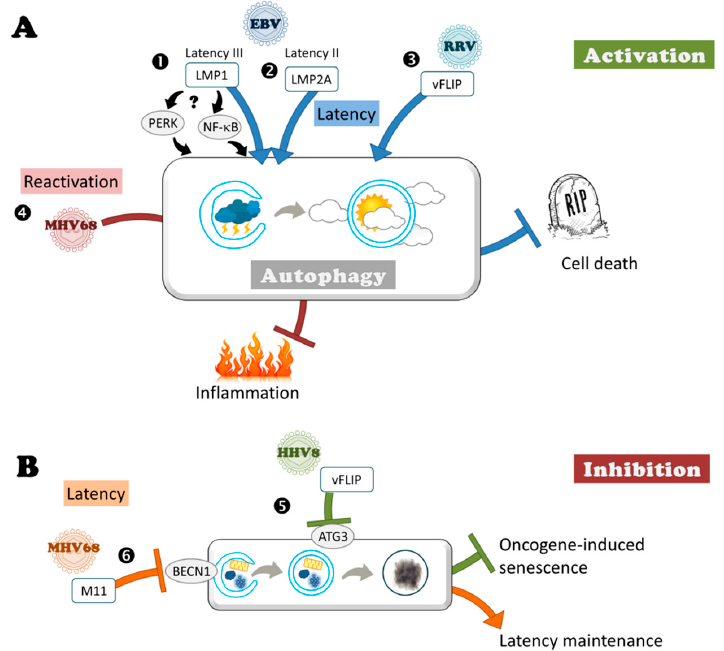
Figure 3. Subversion of autophagy during latency. ( A ) Herpesviruses can benefit from autophagy during latency. LMP1 encoded by EBV during latency III LMP2A during latency II, similarly to vFLIP encoded by RRV protect cell against death by stimulating autophagy (blue T bars), contributing to viral persistence and tumorigenesis. LMP1 induces autophagy either via PERK or via NF- κ B. MHV68 benefits from autophagy to reactivate by limiting virus-induced inflammation (red T bar). ( B ) Herpesviruses can block autophagy during latency. HHV8 via vFLIP blocks autophagy to protect against oncogene-induced senescence (green T bar). The inhibition of autophagy by M11 encoded by MHV68 contributes to the maintenance of latent reservoir (orange T bar).